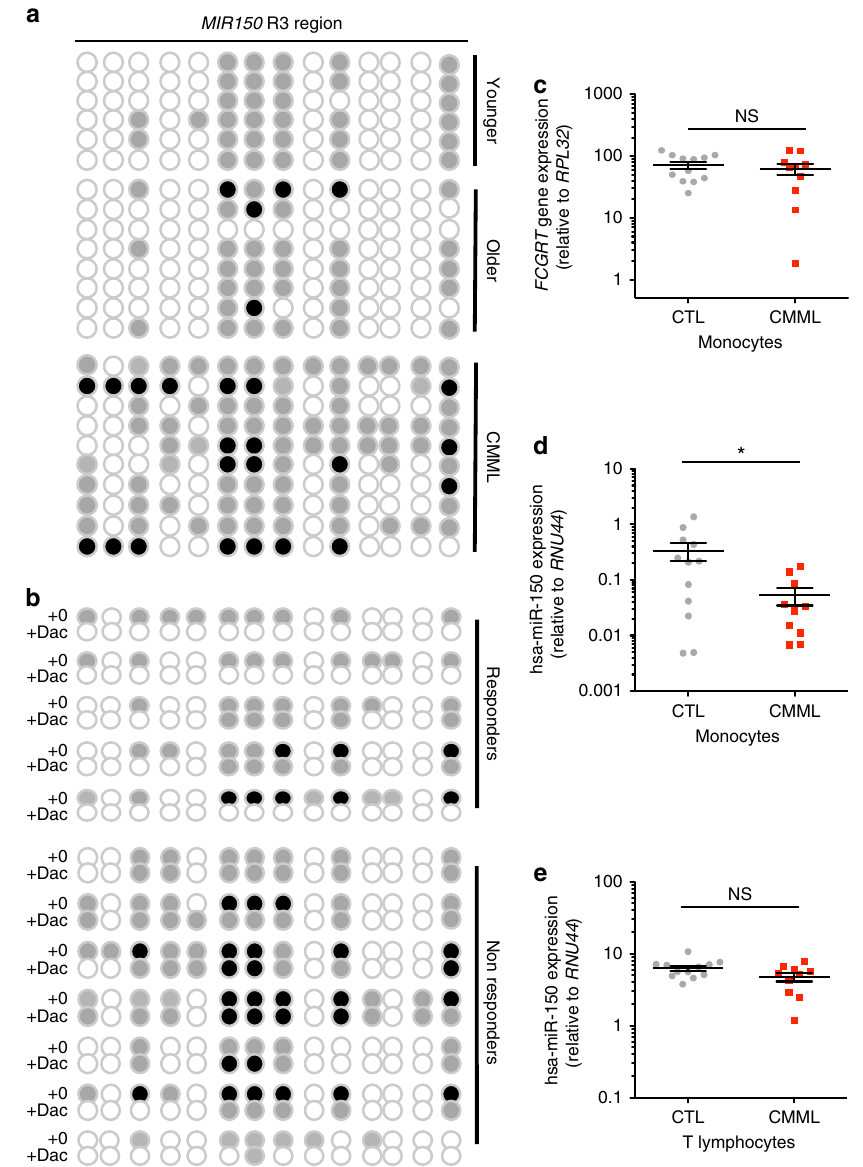
Fig. 6 Methylation of MIR150 region 3 in CMML classical monocytes. a DNA methylation of MIR150 region 3 (R3) was analyzed in sorted CD14 + peripheral blood monocytes from six young (<65 years old) and 8 older (>65 years old) healthy donors and 10 CMML patients. White ball: no methylation; gray ball: methylated on one strand; black ball: methylated on two strands. b DNA methylation status of R3 was analyzed in sorted CD14 + monocytes from 12 CMML patients before ( + 0) and after ( + Dac) decitabine treatment, including fi ve responders and seven non-responders. White ball: no methylation; gray ball: methylated on one strand; black ball: methylated on two strands. c – e qRT-PCR analysis of FCGRT and hsa-miR-150 expression in sorted cells collected from 12 healthy donors (CTL) and 10 CMML patients. Samples are those studied by bisul fi te sequencing. FCGRT gene expression is normalized to RPL32 in sorted monocytes ( c ), hsa-miR-150 expression is normalized to RNU-44 ( d ) in sorted monocytes and in CD3 + T lymphocytes ( e ). Mean ± SEM, unpaired t test: * P < 0.05. NS, nonsigni fi